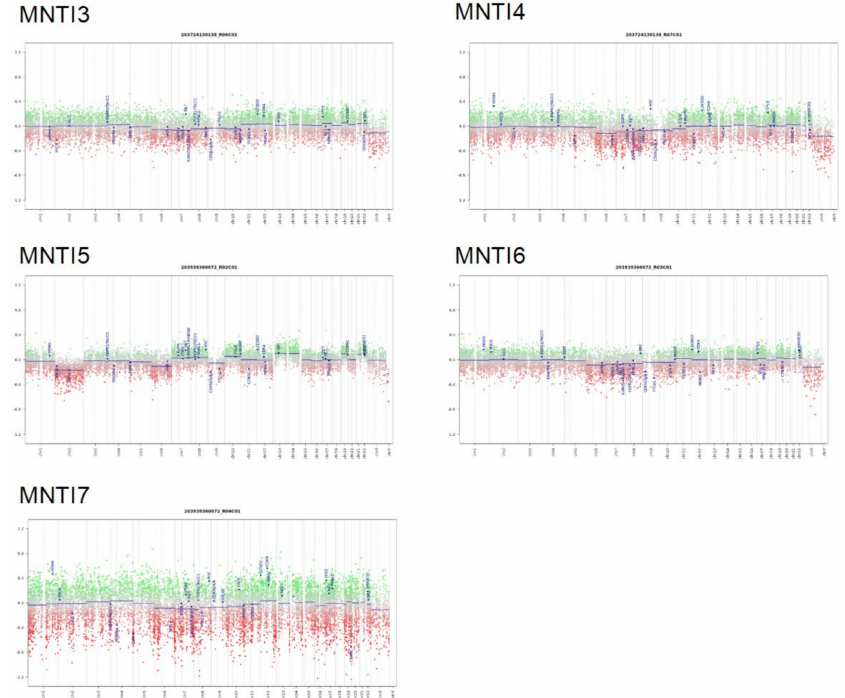
Figure 6. Copy number variation (CNV) profile analysis of the indicated PAT/MNTI. Depiction of structural rearrangements involving autosomes and X/Y chromosome. Gains/amplifications represent positive (green) and losses represent negative (red) deviations from the baseline. Twenty- nine tumor relevant genomic regions are highlighted.